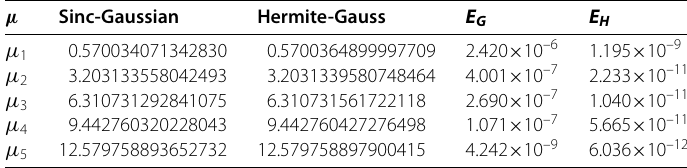
Table 3 Comparison of Hermite-Gauss and sinc-Gaussian, N = 5 and h =